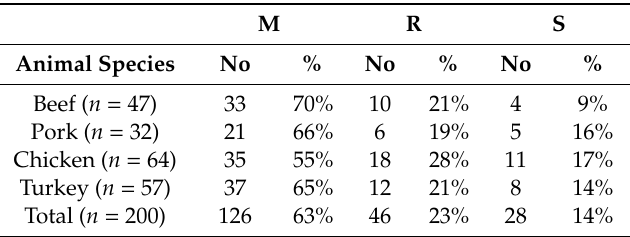
Table 2. Number and percentage of multirresistant (M), resistant (R), and sensitive (S) enterobacterial strains isolated from red meat and poultry